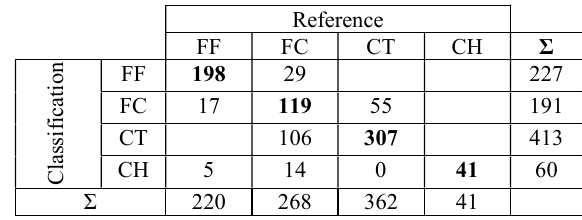
Table 7 . Matrix of confusion of the SAM algorithm. When is analyzed the errors of commission and omission (table 8 and 9), it is noted that, to a greater or lesser extent, all the algorithms showed relatively high performance for three of the four classes analyzed with rates above 85% of accuracy. As with the Kappa indices and global accuracy, the RF and C5.0 classifications achieved better results with lower error rates for both producer and user (consumer).